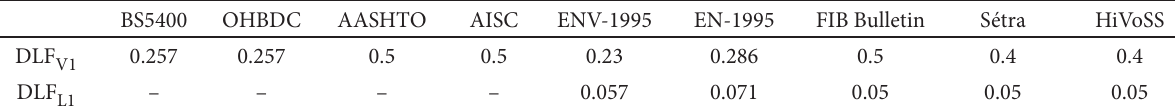
Table 1. DLFs proposed by different Standards and Guidelines